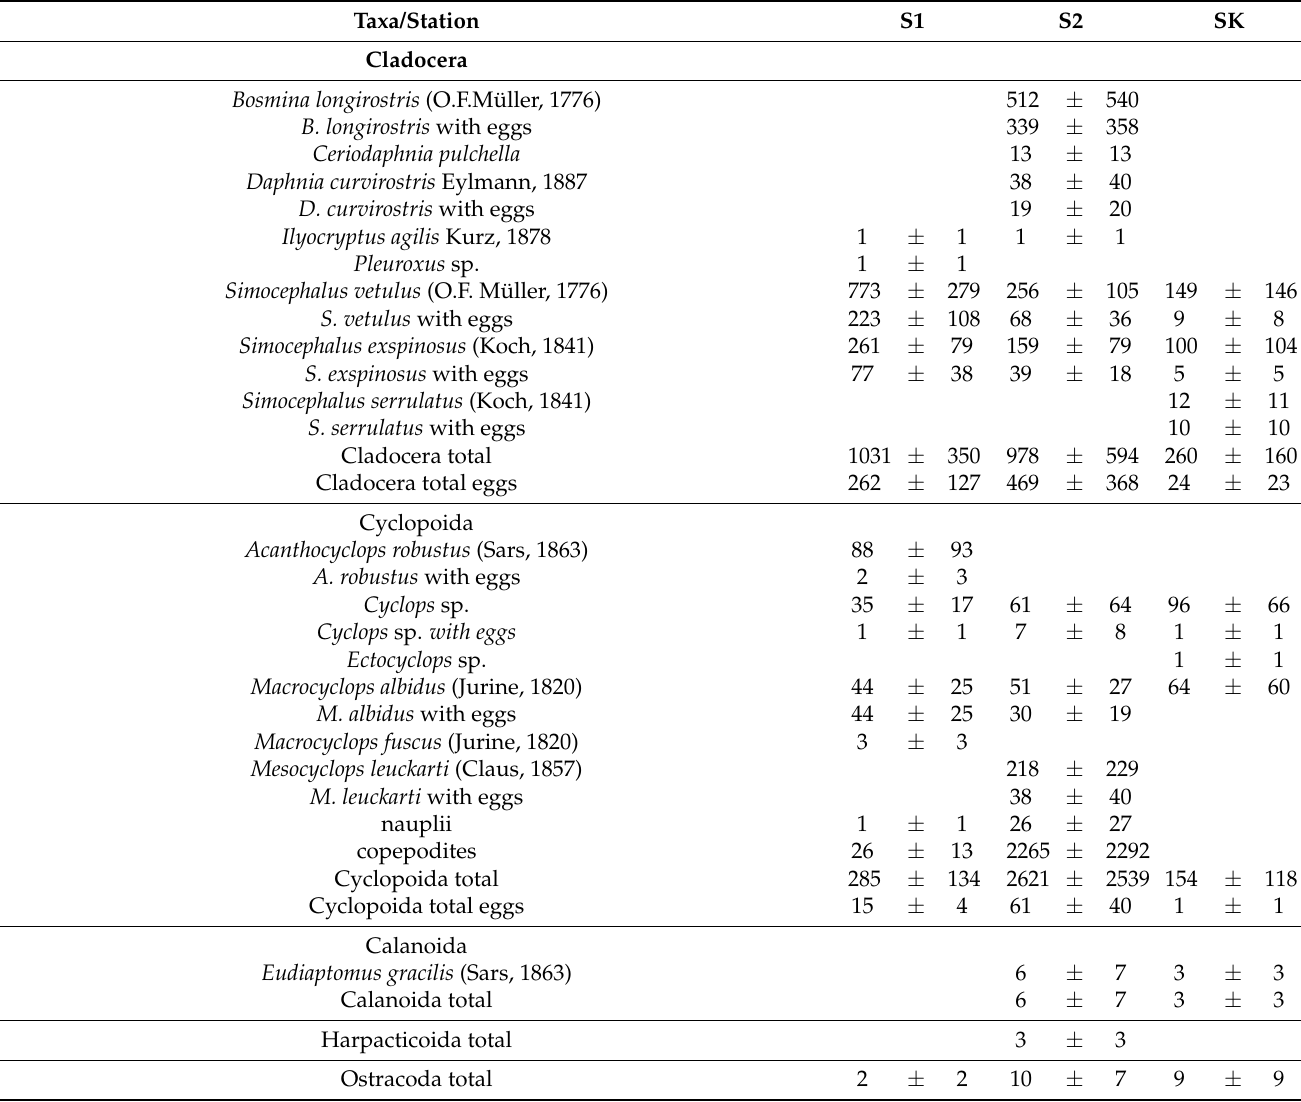
Table 2. Composition and abundance (AVE ± SD) of planktonic crustaceans in the littoral sediment of three SWB.